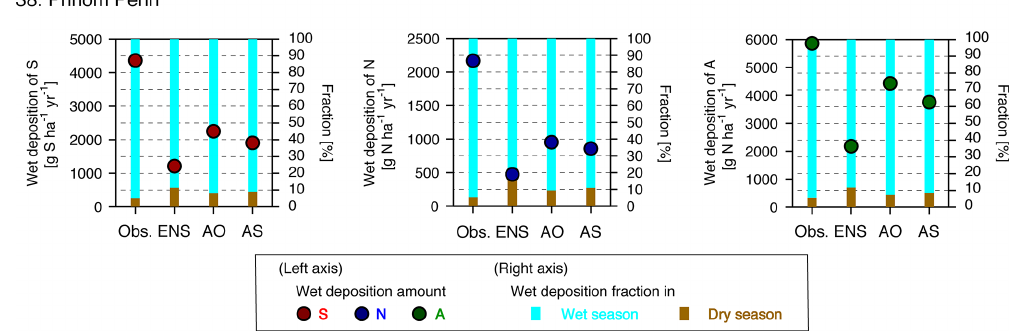
Figure 12. Observed and simulated annual accumulated wet deposition amounts of S, N, and A, and the fraction of wet deposition during the wet and dry seasons in Phnom Penh,